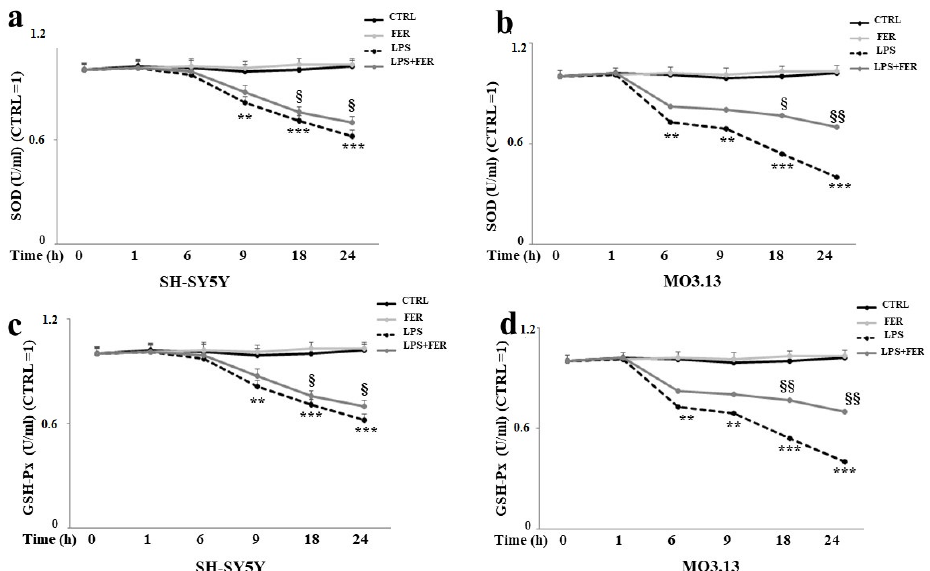
Figure 7. Antioxidative status in SH-SY5Y and MO3.13 cells: evaluation of SOD and GSH-Px activity. The enzymatic activities of SOD and GSH-Px were measured as previously outlined in Figure 6. Panels ( a , b ) refer to the measurement of SOD activity, while panels ( c , d ) express the results obtained from the measurement of GSH-Px activity. The obtained values were normalized with respect to untreated cells. Values are expressed as the mean ± standard deviation (sd). ** denotes p < 0.01 vs. the control; *** denotes p < 0.001 vs. the control; § denotes p < 0.05 vs. LPS; §§ denotes p < 0.01 vs. LPS. Analysis of Variance (ANOVA) was followed by a Tukey–Kramer comparison test.